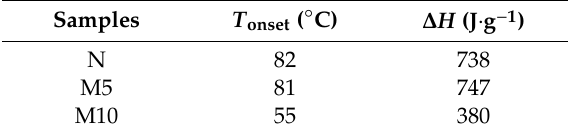
Table 1. Δ H and T onset associated to the thermal transition observed by DSC.